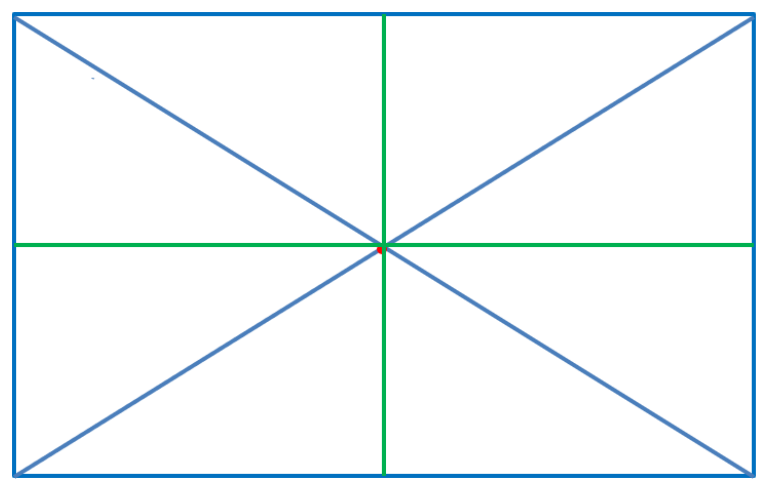
Figure 12. Dividing the wall into four quadrants. Source: the author.